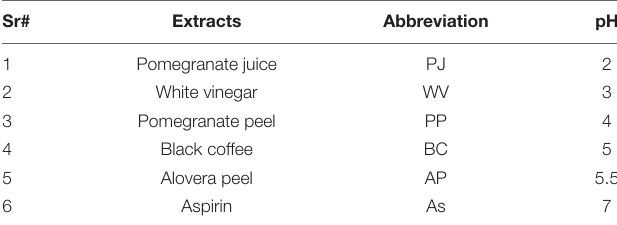
TABLE 1 | Extracts used in the preparation of green-synthesized iron oxide nanoparticles